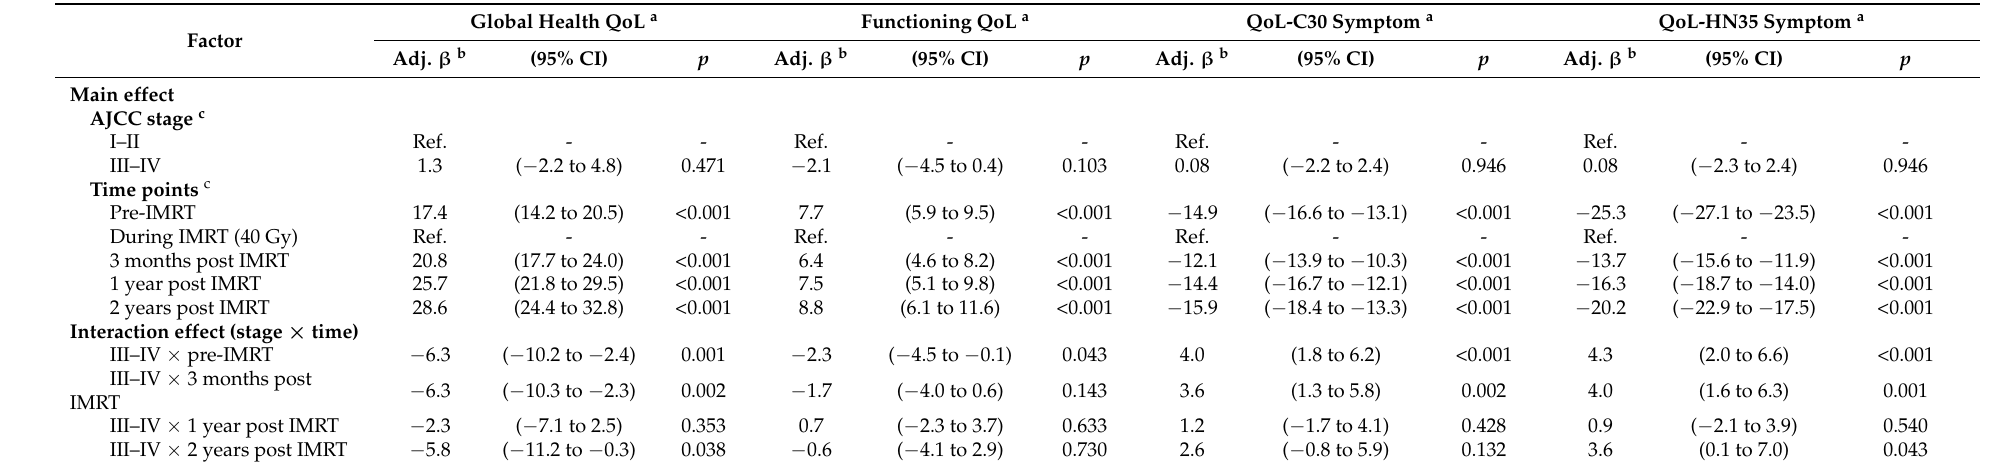
Table 3. Main and interaction effect of AJCC stage and quality of life (QoL) scores at different time